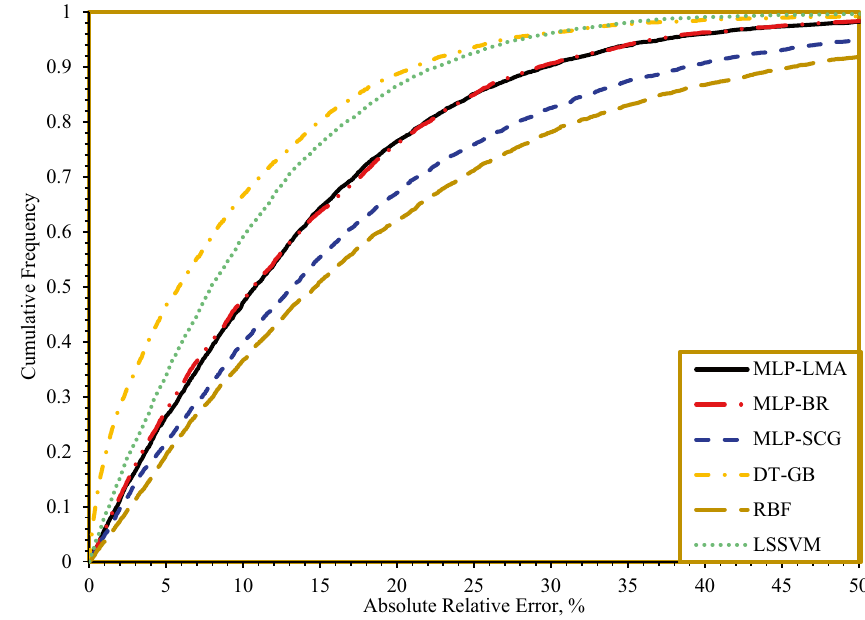
Figure 14. Cumulative frequency vs. absolute relative error of different models proposed in this study.